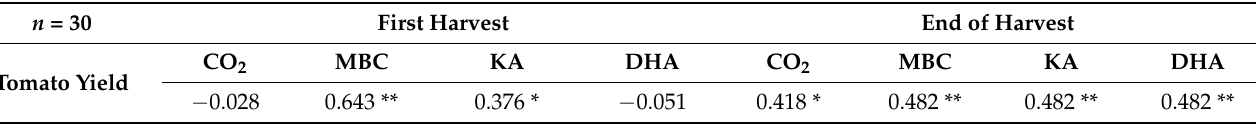
Table 9. Correlation relationships between biological properties and tomato